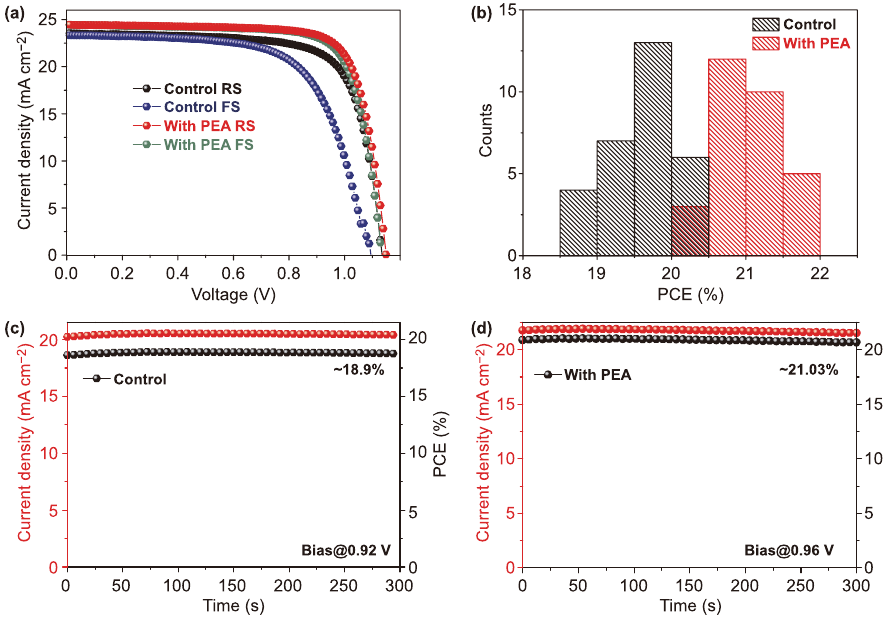
Fig. 7 a J–V curves of the (FAPbI 3 ) 1-x (MAPbBr 3 ) x PSCs with and without PEA. b Histogram of PCE distribution. c Steady-state current den- sity and efficiency at maximum power point of the device without, and d with